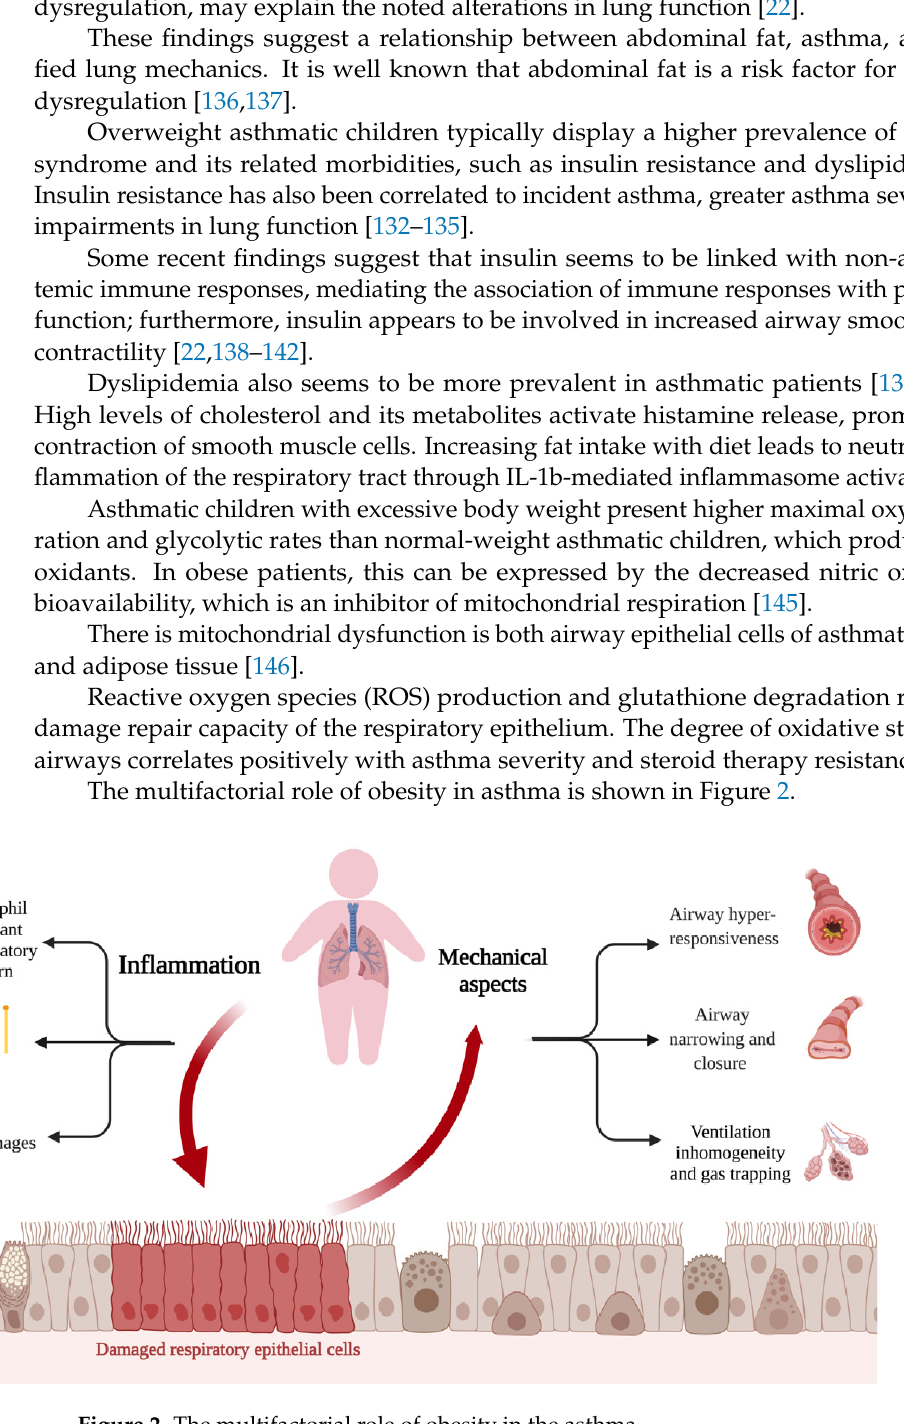
Figure 2. The multifactorial role of obesity in the asthma.